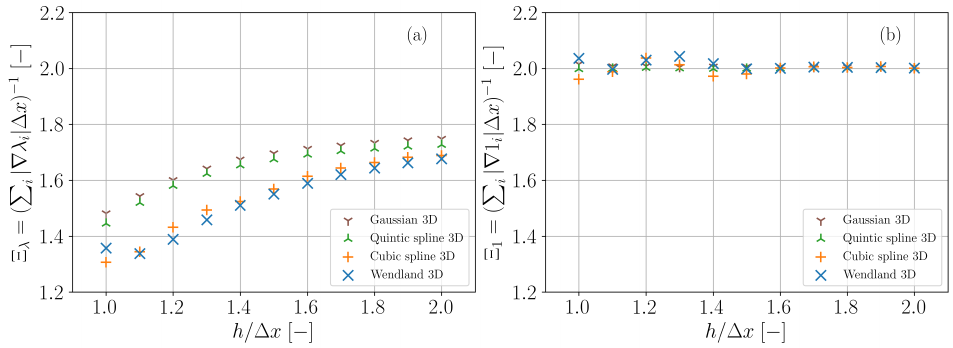
Figure A3. Normalization factors for the surface delta functions for different 3D kernels. ( a ) Based on the minimum eigenvalue of the inverse renormalization tensor. ( b ) Based on the unity field.